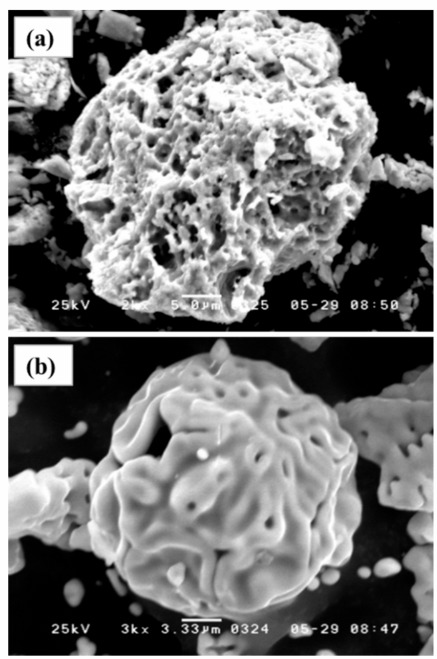
Figure 5. Microstructures of iron particles: ( a ) reduced by hydrogen at 1073 K (800 ◦ C); ( b ) flash reduced at 1623 K (1350 ◦ C). (The figure is adapted from [46], with permission from authors,